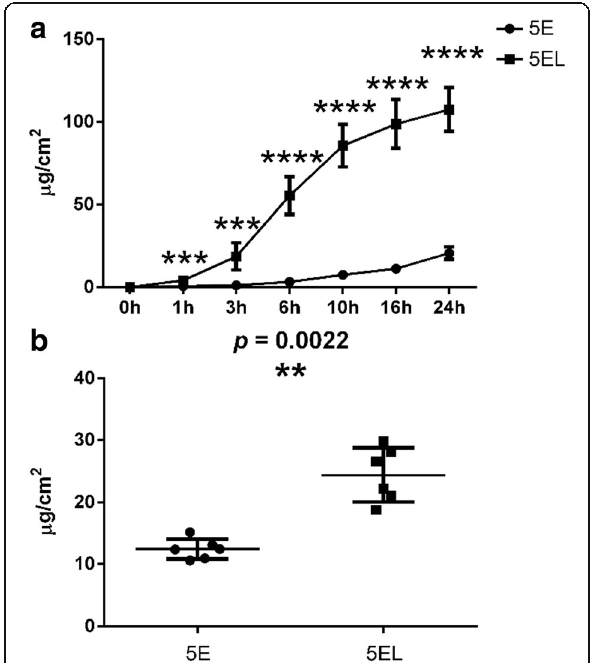
Fig. 2 CO 2 fractional laser promotes 5E permeability through hypertrophic scars in vitro . a Comparison of the permeation of 5E and 5EL group in a 24-h study of human hypertrophic scar in vitro. Values were expressed as the mean ± SD. n = 6. b The accumulative retention of 5-FU in hypertrophic scar in vitro after application for 24 h. n = 6. *** p value < 0.001 was considered statistically extremely significant, **** p value < 0.0001 was considered statistically highly extremely significant